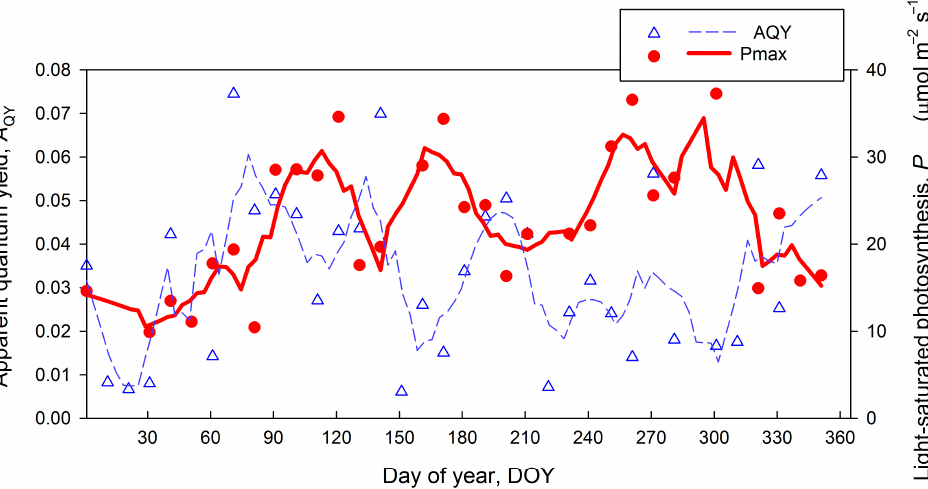
Figure 7. The annual variation of light response parameters with a regression window size of 10 days. A QY and P max represent the apparent quantum yield and light-saturated photosynthesis. The red line and blue dashed line represent the fitting curves of A QY and P max.